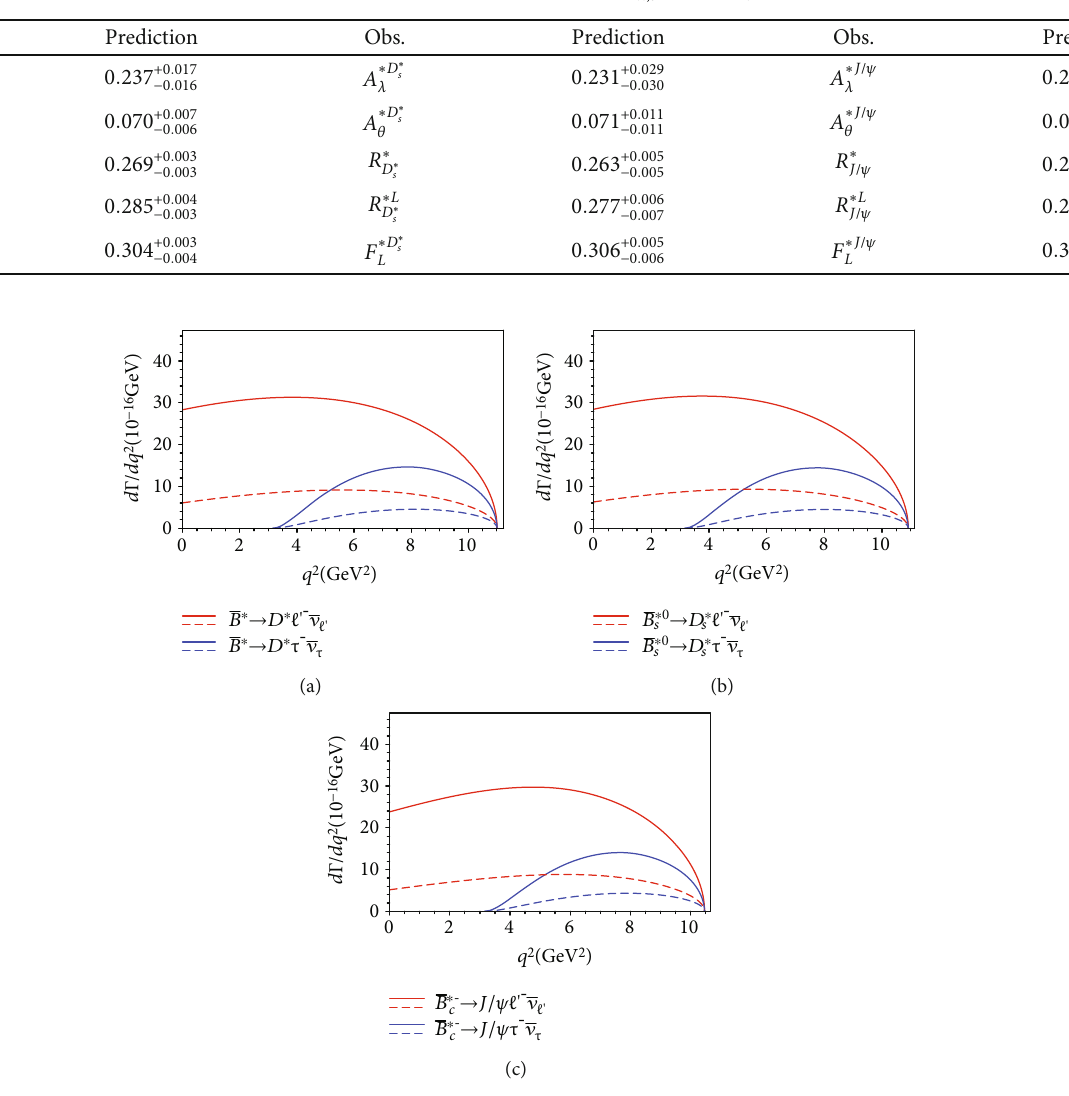
Table 4: Predictions for q 2 -integrated observables A ∗ V